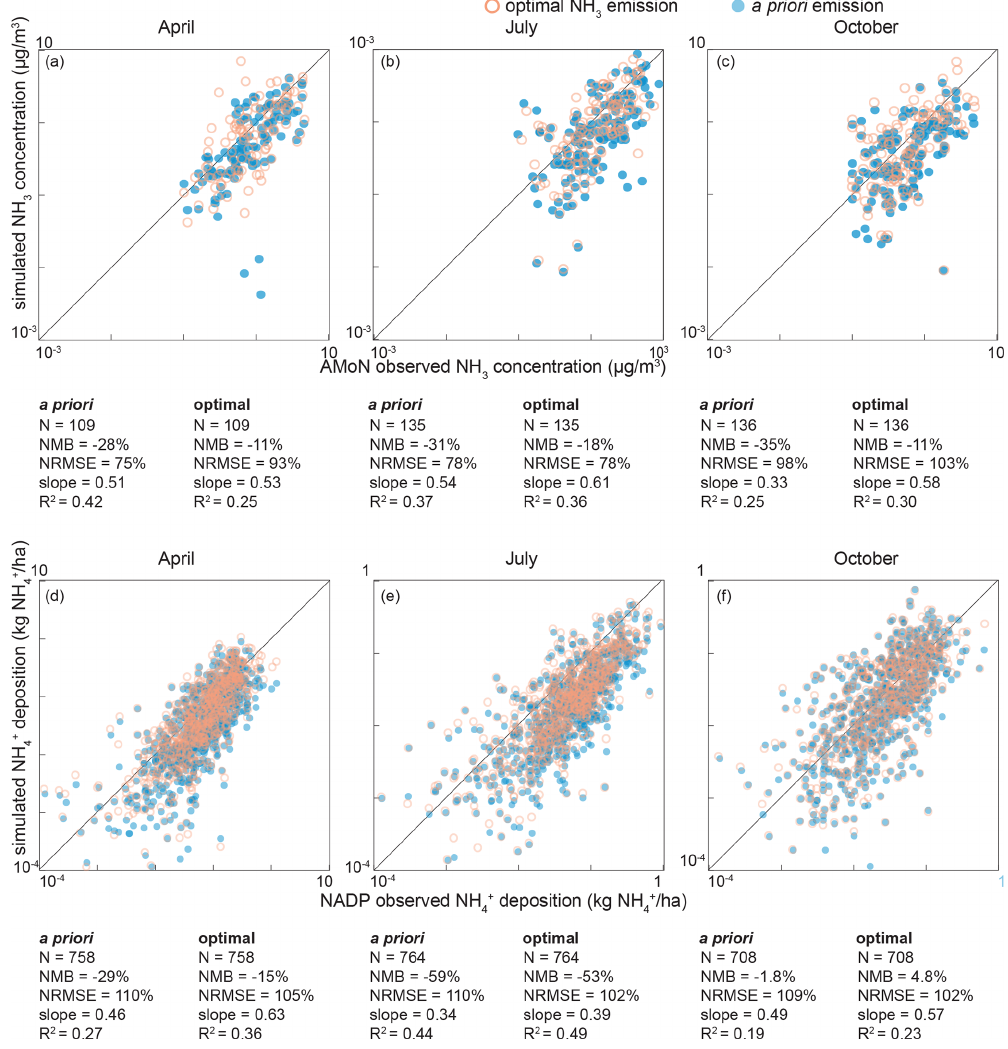
Figure 4. Evaluation of the simulated NH 3 surface concentration (a, b, c) and NH + wet deposition (d, e, f) against biweekly NH 3 concen- 4 tration observations from AMoN and weekly NH + wet deposition observations from NADP, respectively. The orange circles and blue dots 4 represent comparison using the a priori and optimized NH 3 emission estimates, respectively. Summary statistics including sample size ( N ), normalized mean bias (NMB), normalized root mean square error (NRMSE), least square error regression slope and intercept, and R square ( R 2 ) for all comparisons are listed below the